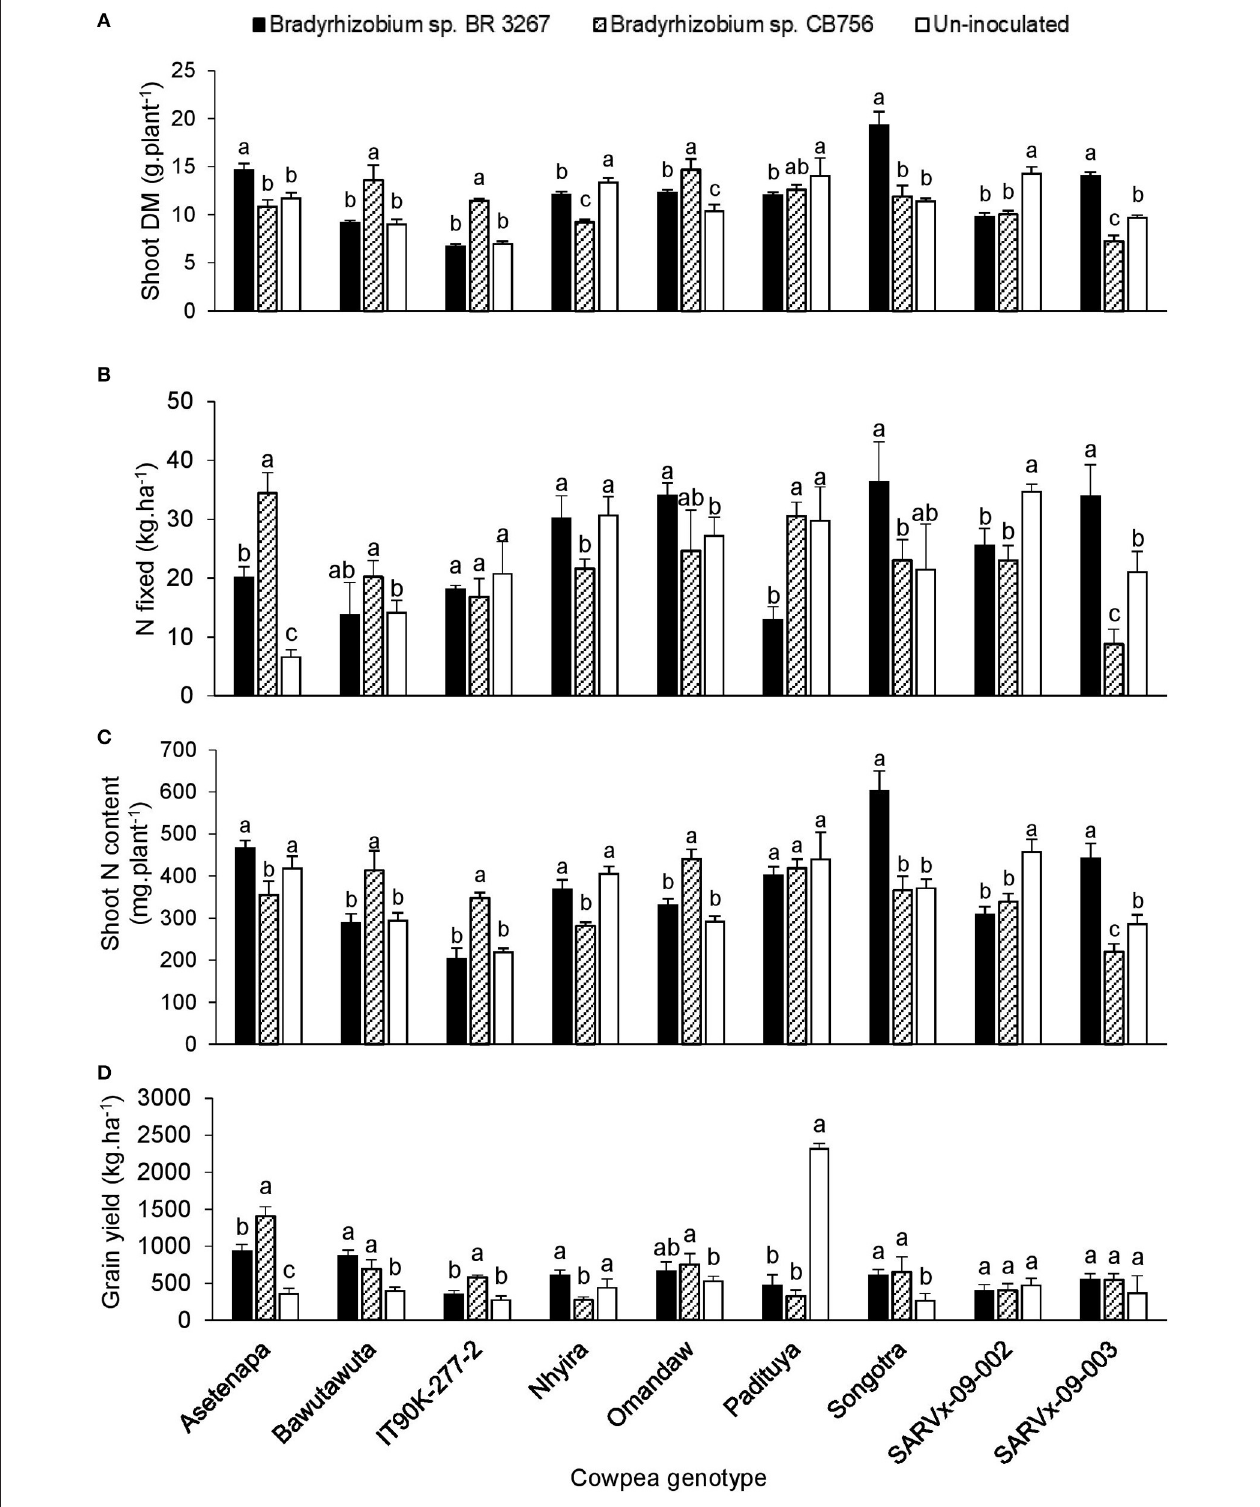
FIGURE 2 | The interactive effect of genotype x inoculation on (A) shoot dry matter, (B) N-fixed, (C) N content, and (D) grain yield of 9 cowpea genotypes planted in Savelugu in 2013. For each genotype, bars with dissimilar letters are significantly different at p ≤ 0.05. Error bars represent standard errors.